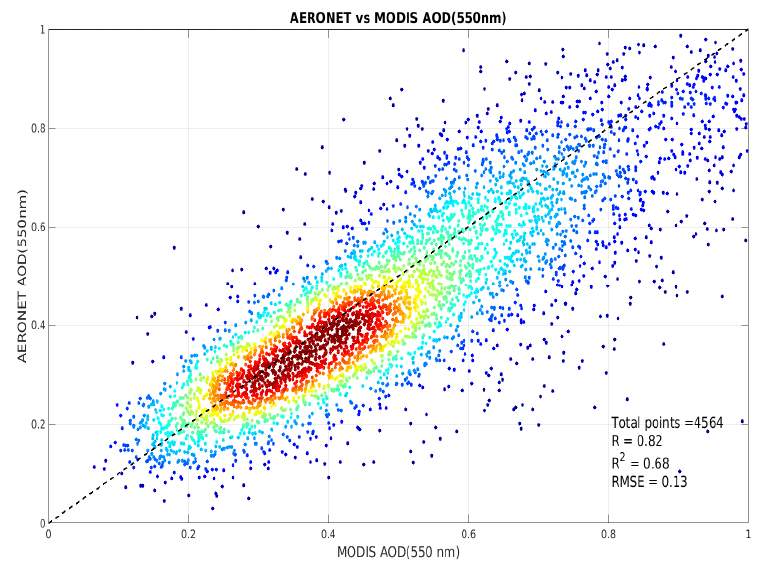
Figure A2. Comparison between Moderate Resolution Imaging Spectroradiometer–Multiangle Implementation of Atmospheric Correction (MODIS–MAIAC) AOD and Aerosol Robotic Network (AERONET) AOD over India. Three AERONET sites with multi-year data are chosen for the analysis—Kanpur (26.5 ◦ N, 80.3 ◦ E), Gandhi College (25.9 ◦ N, 84.1 ◦ E) and Jaipur (26.9 ◦ N and 75.8 ◦ E). Kanpur, Gandhi College and Jaipur sites have been operating since 2001, 2006 and 2009, respectively.